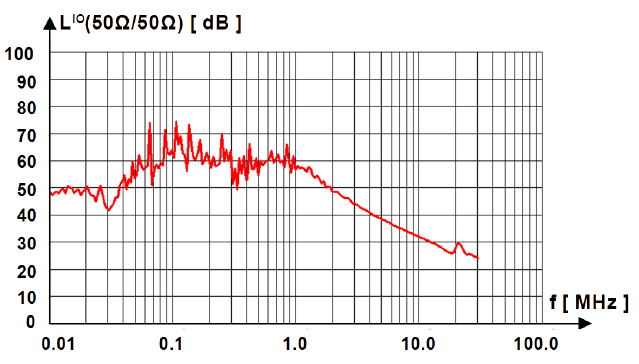
Figure 11. The insertion loss of the conversion from the common to the differential mode of the exemplary